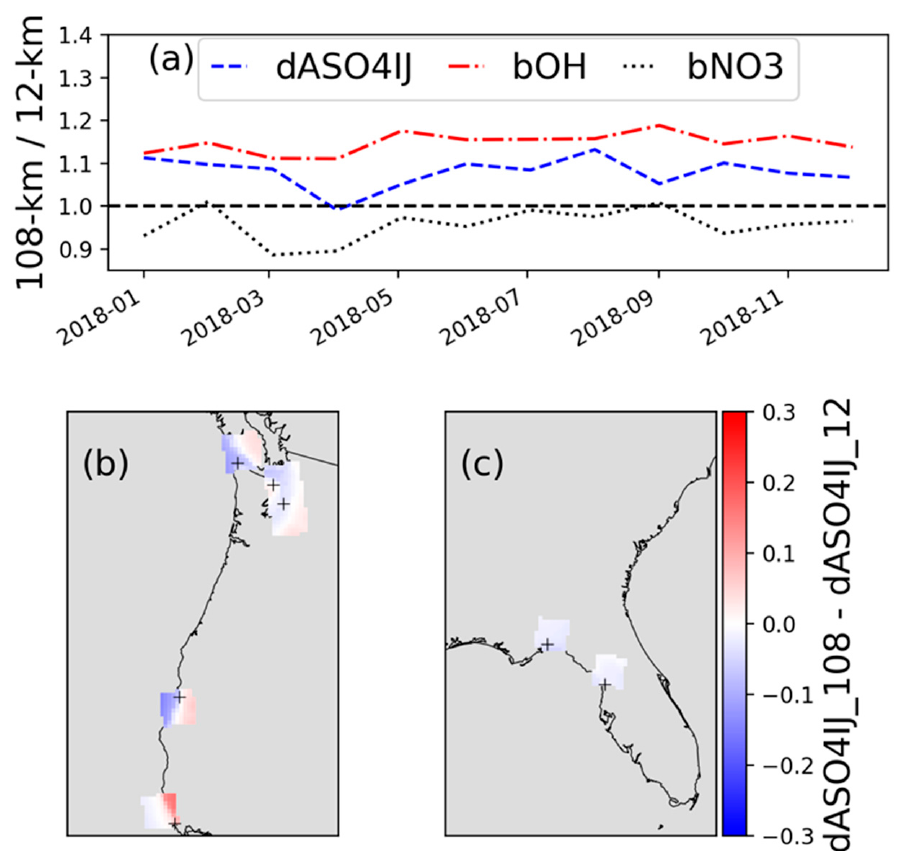
Figure 10. ( a ) Ratios of 108 km to 12 km sulfate enhancement (dSO4, blue solid), DMS simulation OH concentration (bOH, red dashed), and DMS simulation NO 3 (bNO 3 , blue dotted) for ocean cells within the 12US1 domain. dSO4, bOH, and bNO 3 are shown on the y-axis and dates are shown on the x-axis; ( b , c ) annual mean difference in sulfate enhancements between 108 km and 12 km horizontal grid resolutions zoomed in on the Pacific Coast ( b ) and Florida ( c ). Seven IMPROVE sites were used in the calculation: PORE1 and REDW1 in California, MAKA2, OLYM1, and PUSO1 in Washington, and CHAS1 and SAMA1 in Florida.